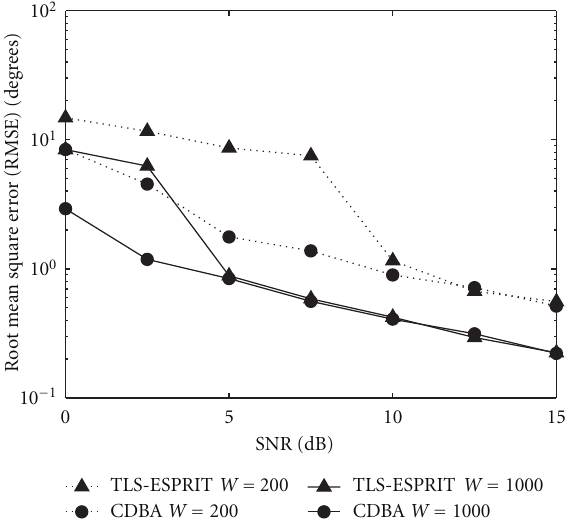
Figure 1: Root mean square error (RMSE) of angle estimation in degrees versus signal-to-noise-ratio (SNR) in dB for ( θ 1,2 = 30 ◦ ,75 ◦ ).